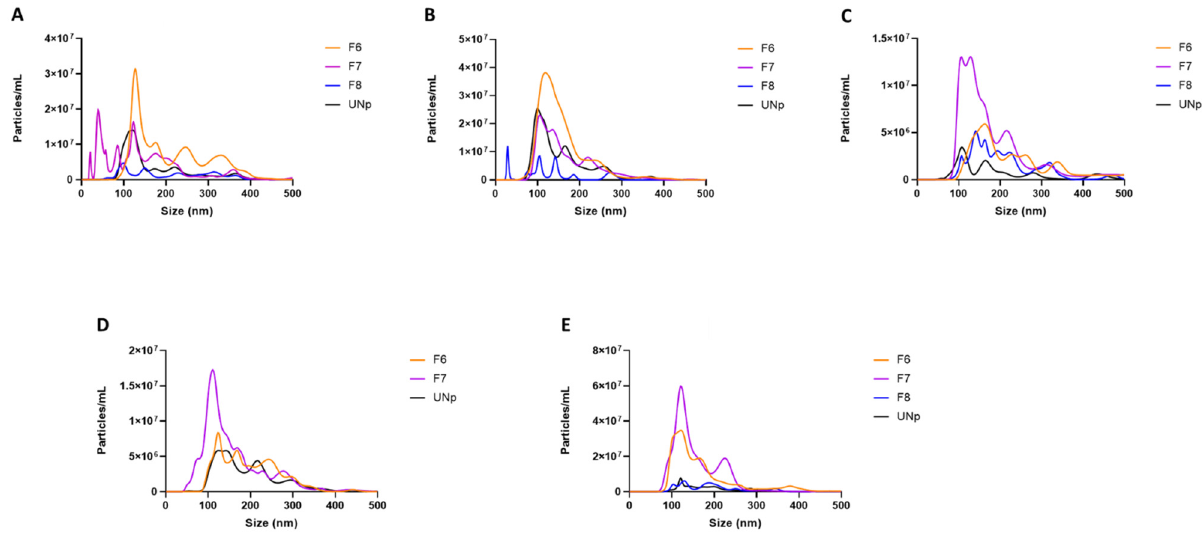
Figure 1. Size distribution of human urinary particles isolated by ultracentrifugation alone versus ultracentrifugation followed by SEC column-purification. ( A – E ) Human urine was collected from subjects listed in Table 1. Particle diameter size and concentration determined by nanoparticle tracking analysis for human urinary particles isolated using ultracentrifugation and remained unpurified (UNp) or isolated via ultracentrifugation and then fractionated using SEC column-purification, with fraction 6 (F6), fraction 7 (F7), and fraction 8 (F8) being analyzed. A 500 nm size cutoff was used for data representation. ( D ) F8 was below the limit of detection.